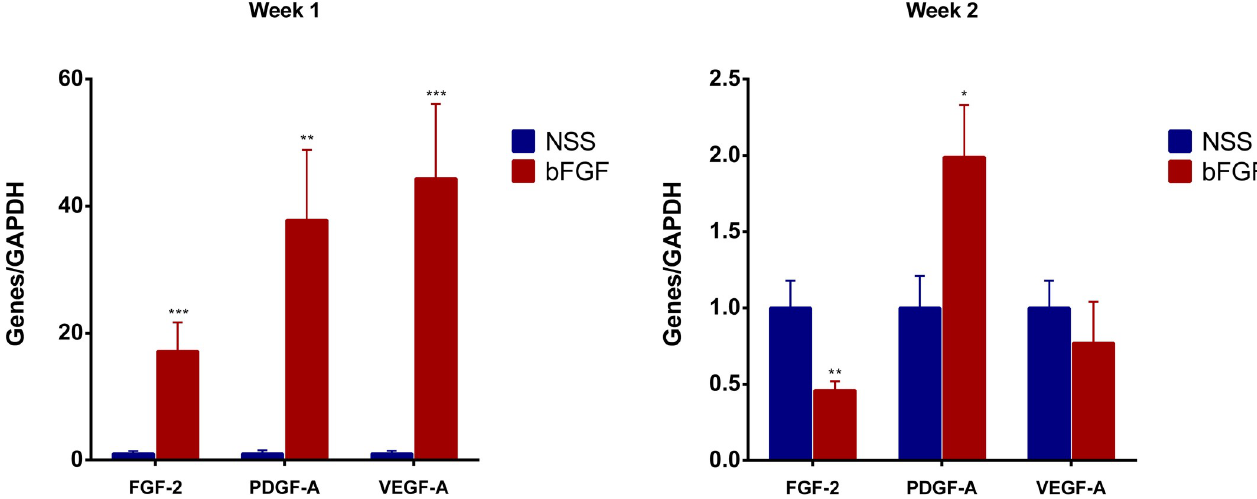
Fig 4. The comparison of the angiogenesis-related genes expression at Weeks 1 and 2 after implantation. The relative expressions of FGF-2, PDGF-A and VEGF-A were strongly up-regulated in the bFGF group at Week 1 ( �� p < 0.01, ��� p < 0.001). The expression of FGF-2 was lower in the bFGF group than in the NSS group ( �� p < 0.01), while that of PDGF-A was higher in the bFGF group than in the NSS group ( � p < 0.05).